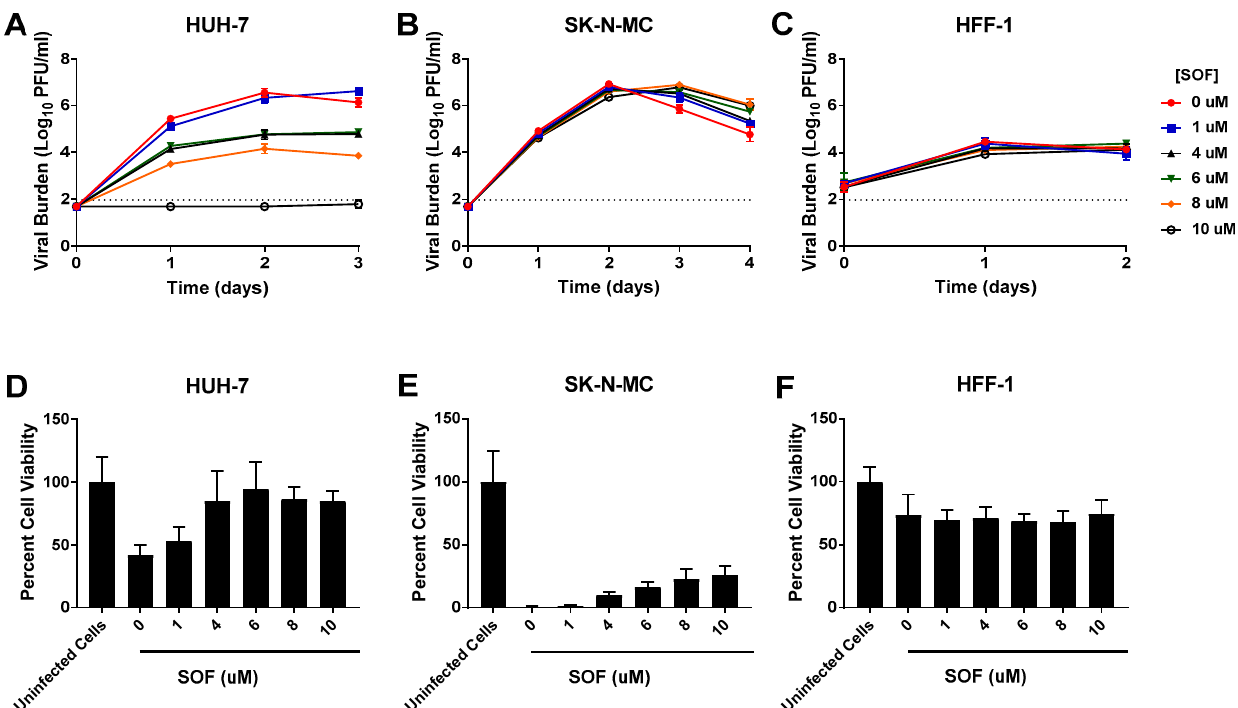
Figure 3. Antiviral activity of sofosbuvir (SOF) against dengue virus (DENV) in HUH-7, SK-N-MC, and HFF-1 cells ( A – C ). HUH-7 ( A ) cells were infected at a multiplicity of infection (MOI) of 0.01, and SK-N-MC ( B ) and HFF-1 ( C ) cells were infected at an MOI of 0.1. Infected cells were treated with different concentrations of SOF. Viral burden was quantified via plaque assay on Vero cells, and reported as log10 plaque forming units per mL (PFU/mL). Data points represent the mean of three independent samples, and error bars correspond to one standard deviation. The dashed line signifies the assay limit of detection. ( D – F ) Effect of SOF treatment on cell viability of DENV-infected HUH-7 ( D ), SK-N-MC ( E ), and HFF-1 ( F ) cells. HUH-7, SK-N-MC, and HFF-1 cells were infected with DENV at MOIs of 0.01, 0.1, and 1, respectively, then treated with different concentrations of SOF. Cell viability was measured after three days with the commercially available WST-1 assay according to manufacturer specifications. Cell viability is reported as percent cell viability relative to an untreated, uninfected control. Columns represent the mean of 6 independent samples, error bars represent one standard deviation.